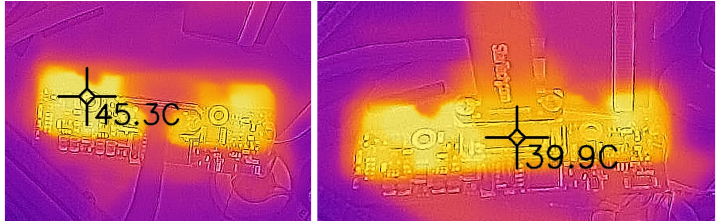
Figure 13. Photographs of AFE electronics taken with a thermal imaging camera (Flir One by Teledyne) superimposed on regular image (with small misalignment due to parallax). The black crosses show the temperature measurement points. One can see the connected USB-C